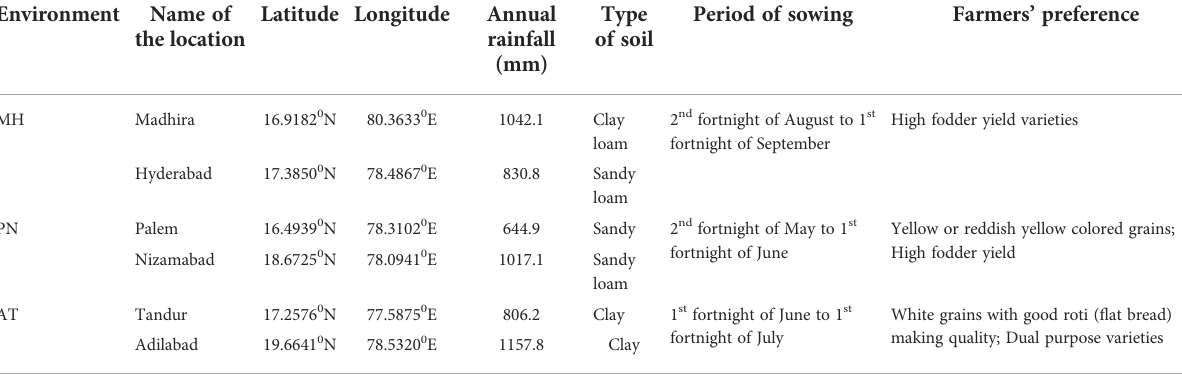
TABLE 2 Details of the 3 environments tested for evaluation of sorghum varieties from 2018-19 to 2020-21 in Telangana State, India.